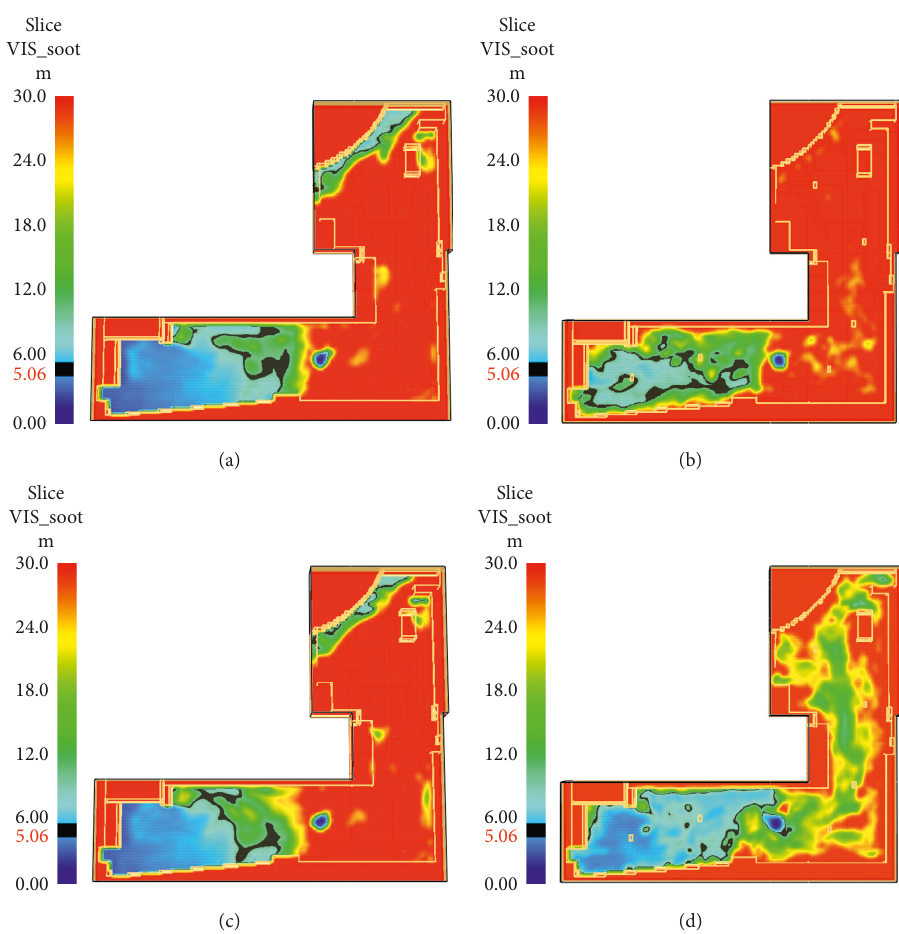
Figure 3: Critical time of fire hazard for scenario B. (a) B00, (b) B01, (c) B10, and (d) B11.